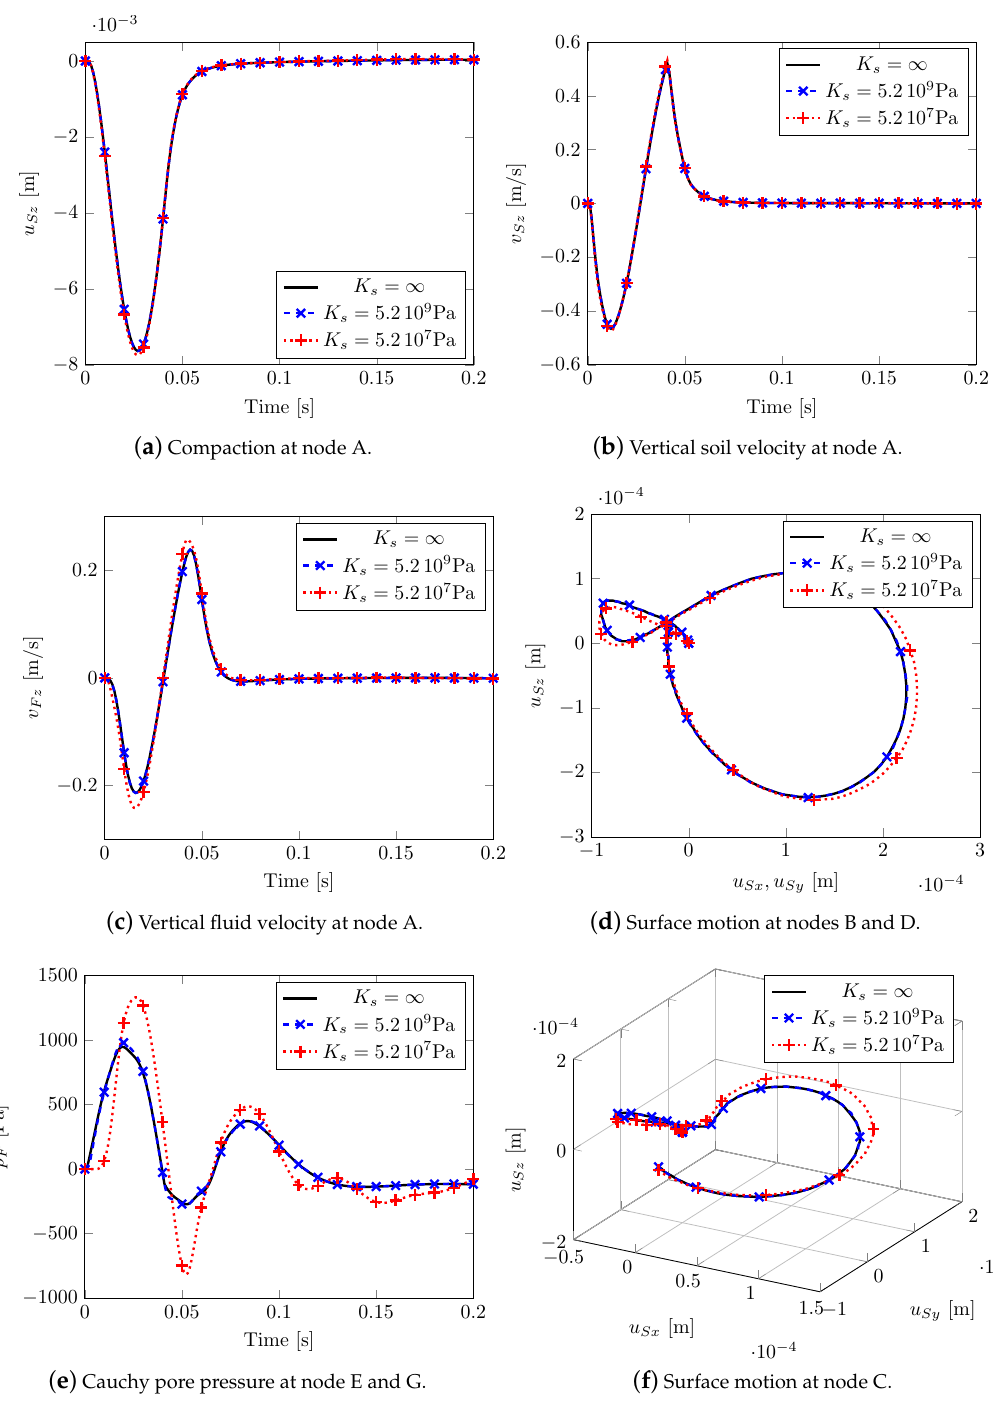
Figure 8. 3D isotropic soil